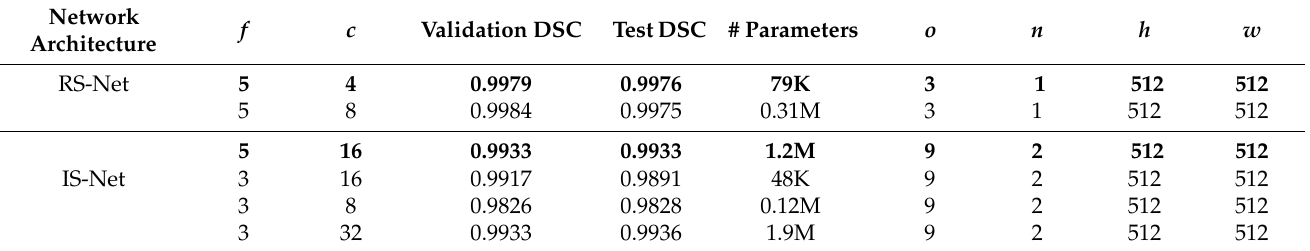
Table 2. The compression experiments with different architectural parameters for both RS and IS networks. The selected configuration for each network is highlighted in